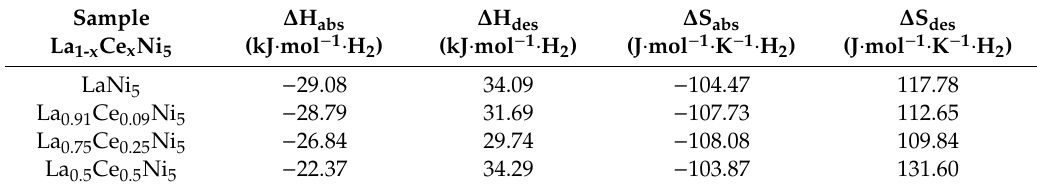
Table 3. Absorption and desorption enthalpies and entropies estimated based on van ’t Hoff’s plots